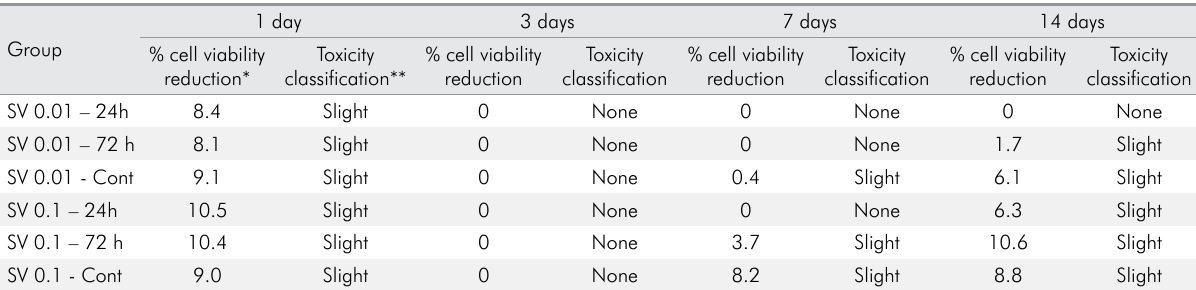
Table 3. Classification of cytotoxicity of the experimental groups at each time point, according to ISO 10993-5:2009 (E). 1 day Group